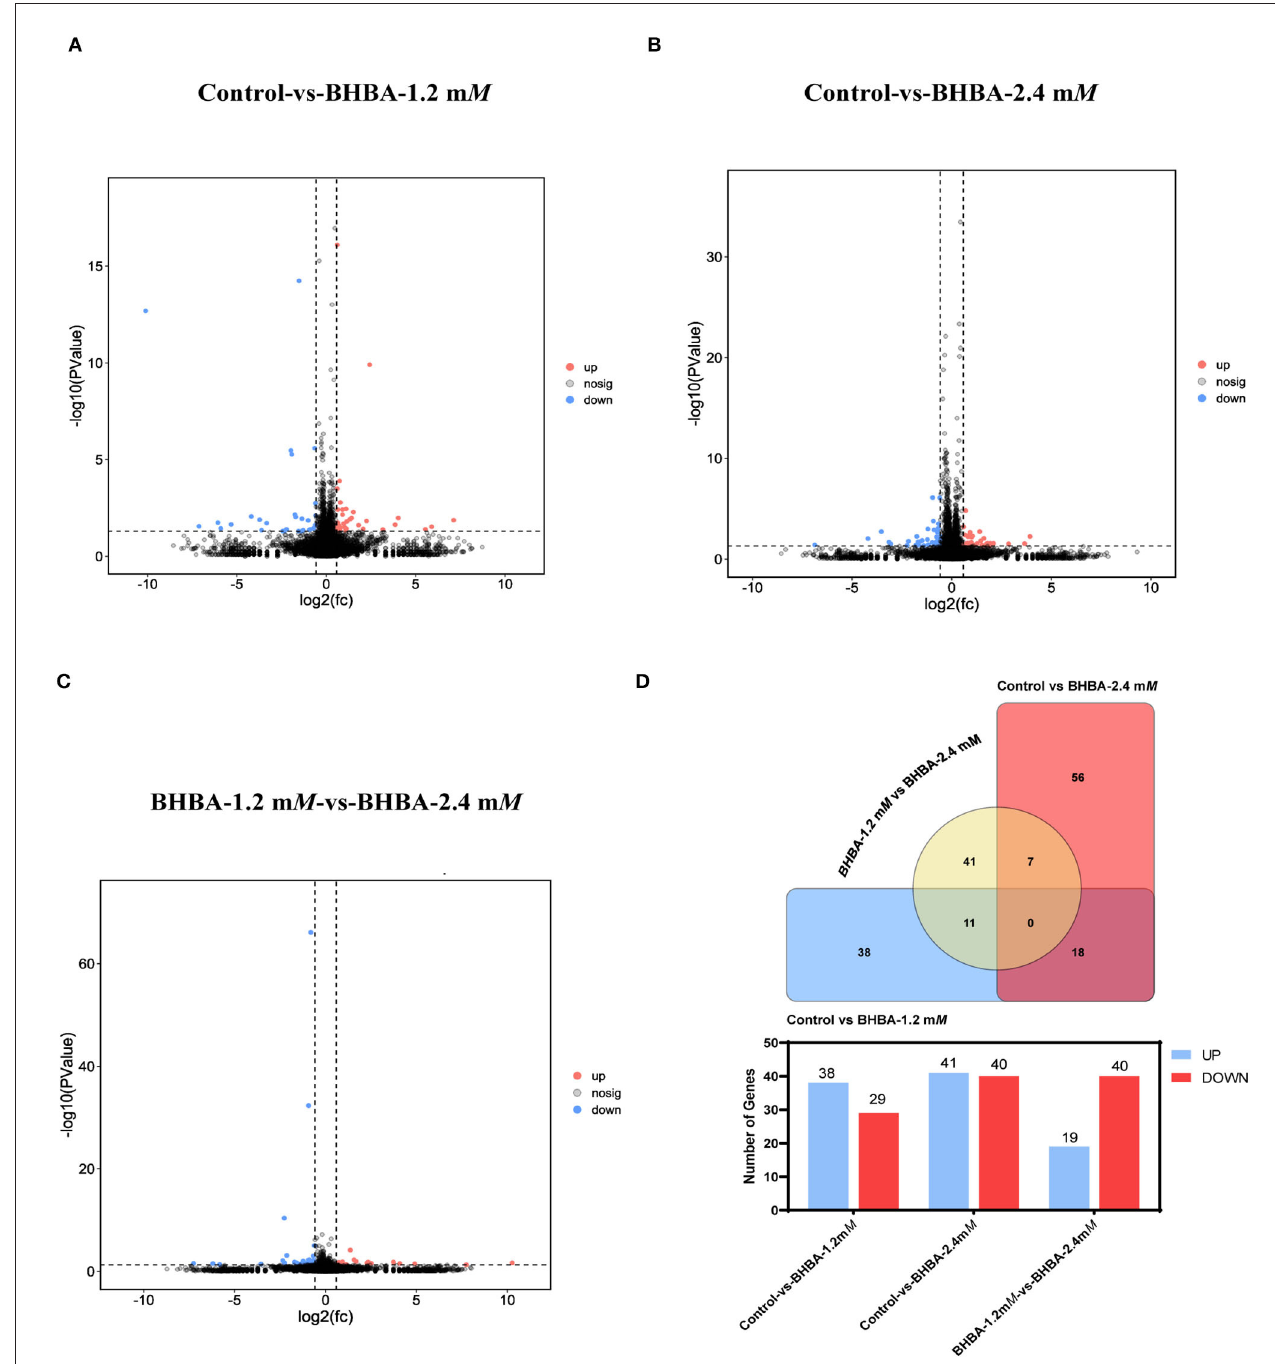
FIGURE 3 | Significant DEGs were identified between the three groups. The screening criteria for significant DEGs was P < 0.05 and | FC | > 1.5. (A–C) show volcanic plots of the significant DEGs across the three groups. (D) The Venn diagram shows the common and specific DEGs in the three comparison groups. And the bar chart shows the number of significant DEGs in the three